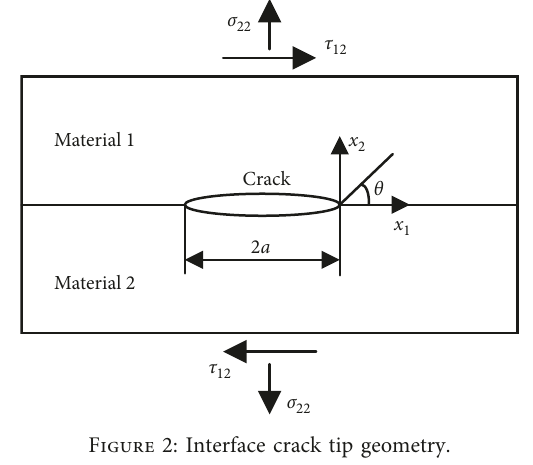
Figure 2: Interface crack tip